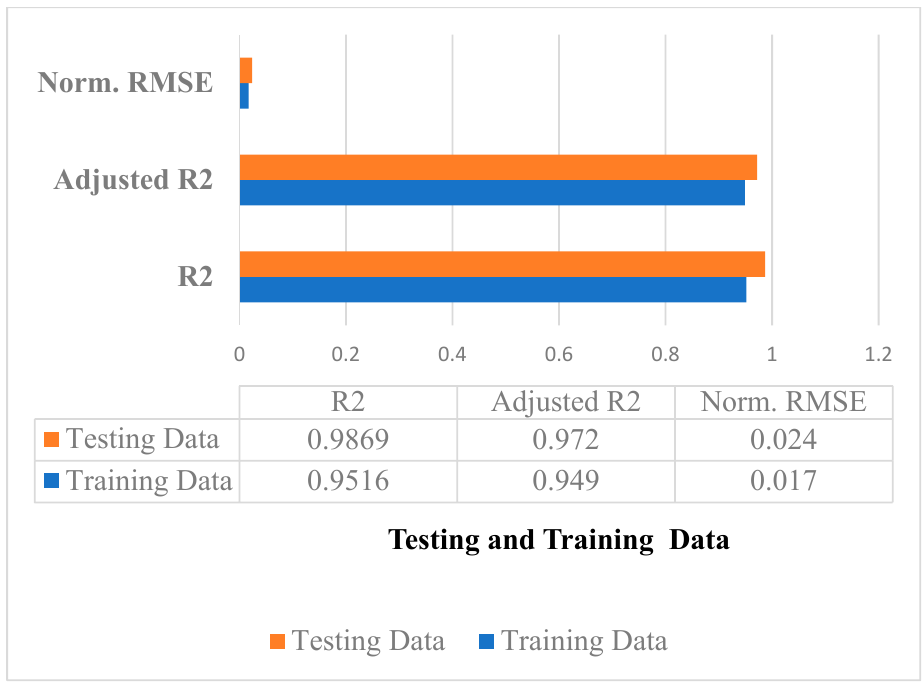
Figure 9. Performance metrics of LSTM + CRP. Table 5. Multiple epochs of training data R 2 vs. various prediction techniques.